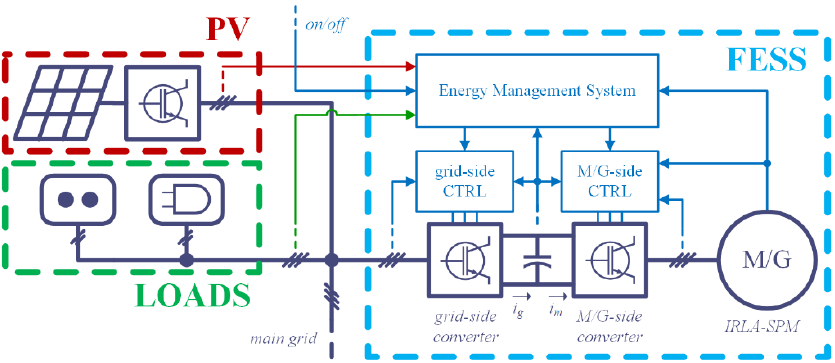
Figure 1. Overview of the FESS integrated within a household electric system.